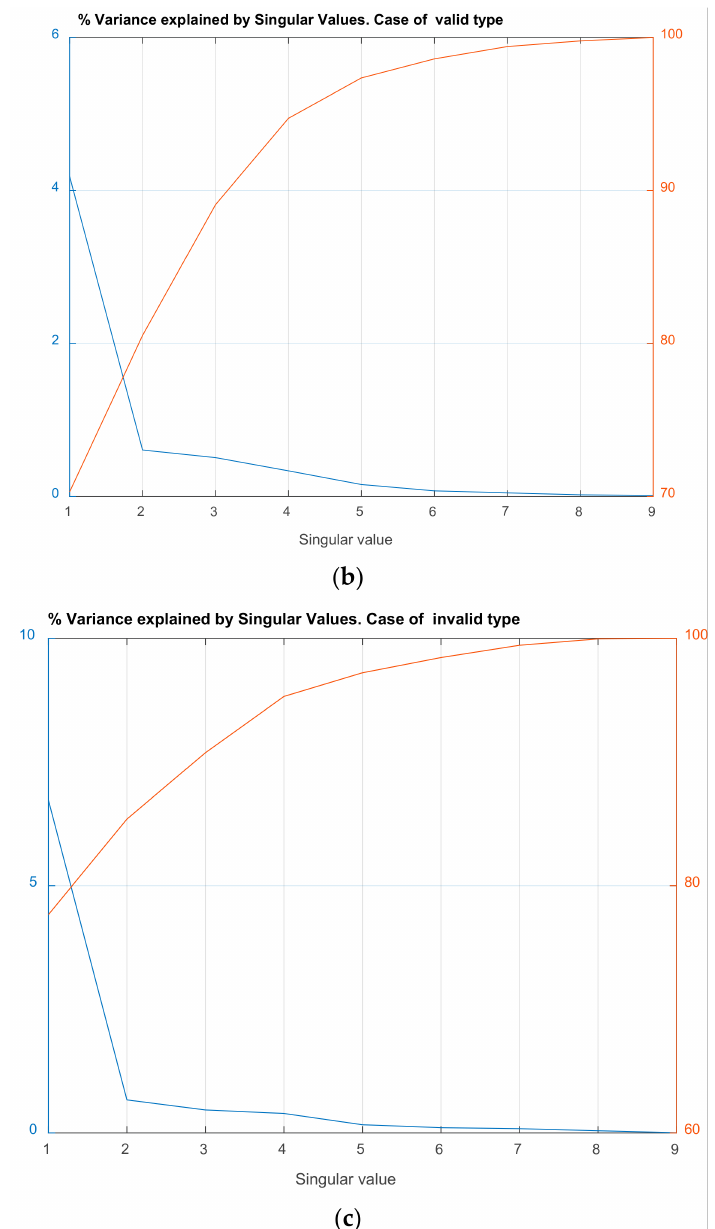
Figure 11. ( a ) Time series of average MSE values at channels per subject, extracted from EEGs recorded at participant’s scalp, when they are exposed in a cognitive load induced by an invalid syllogism. ( b ) Plot of squared singular values and percentage of the total variance explained. The first four singular values explain about 95% of the variance. It shows actually the effect of dimensionality reduction attained by the action of the SVD on the Correlation matrix R. Case: Valid syllogism. ( c ) Plot of squared singular values and percentage of the total variance explained. The first four singular values explain about 95% of the variance. It shows actually the effect of dimensionality reduction attained by the action of the SVD on the correlation matrix R. Case: invalid